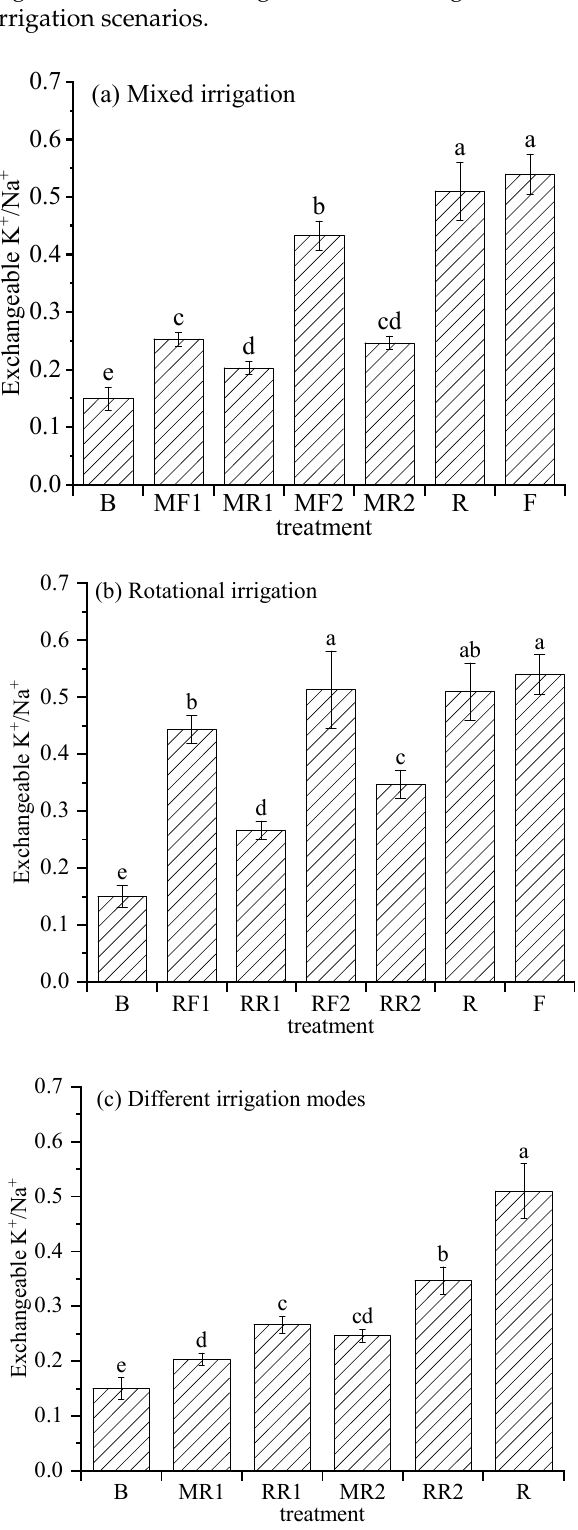
Figure 4. Variation in soil exchangeable K + /Na + under different irrigation scenarios. Note: different lowercase letters on the points represent the significant differences at the level of